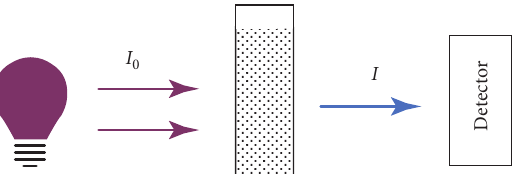
Figure 3: UV light produced by a 595nm UV flashlight passes through a transparent solution. The amount of light transmitted through the solution is detected by a